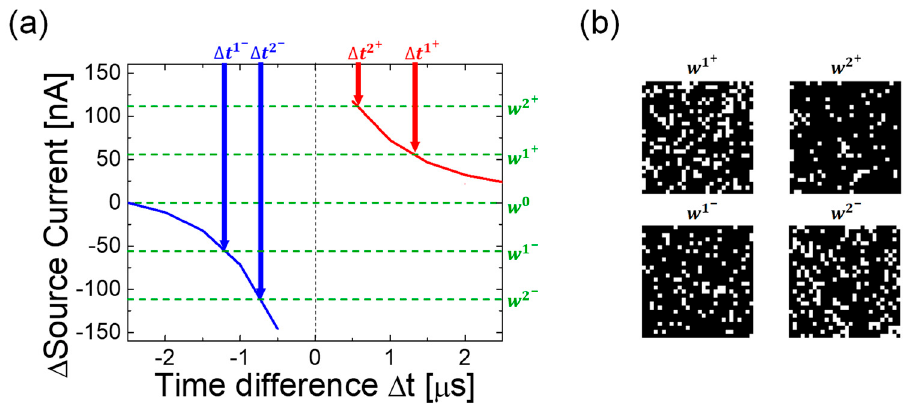
Figure 5. ( a ) Example of extracting the timing differences from STDP curve with 5-level quantized weights; ( b ) extracted weight map having the value of w 2 − , w 1 − , w 1 + , w 2 + connected to the first neuron in the first hidden layer.